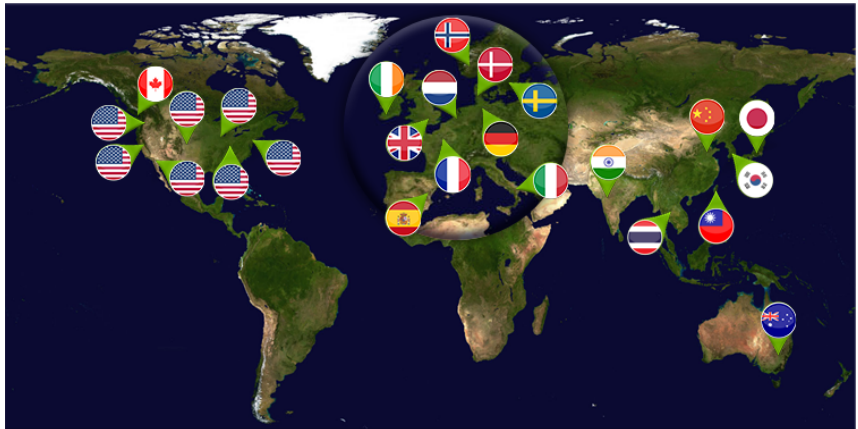
Figure 2. Geographic distribution of Earth System Grid Federation sites participating in CMIP6 as of April 2020. The figure was generated using a world map taken from Shutterstock, and the country flags are taken from